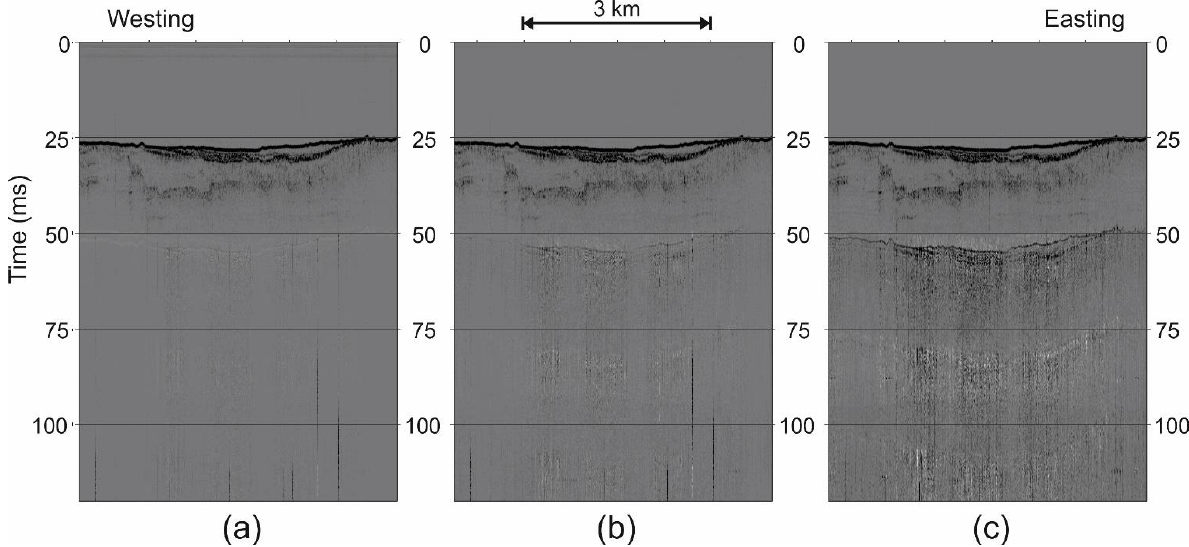
Figure 5. Gapped deconvolution for the same data as in Figure 4, i.e., using α exponents: α = 1 ( a ), α = 1.473 ( b ), and α = 2 ( c ). The best result in terms of multiple attenuation is obtain for α = 1 ( a ), as the sea water approximates well a perfectly elastic medium.